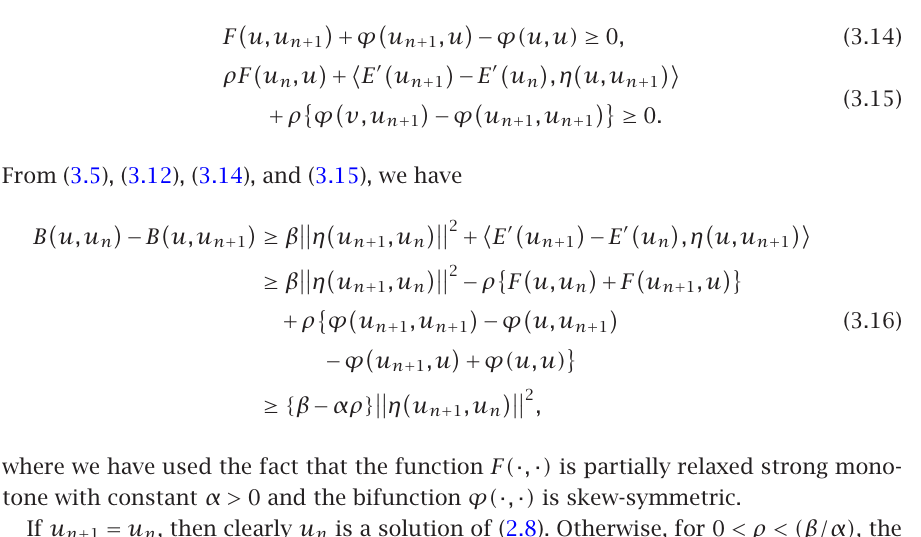
Algorithm 3.7 . For a given u iterative